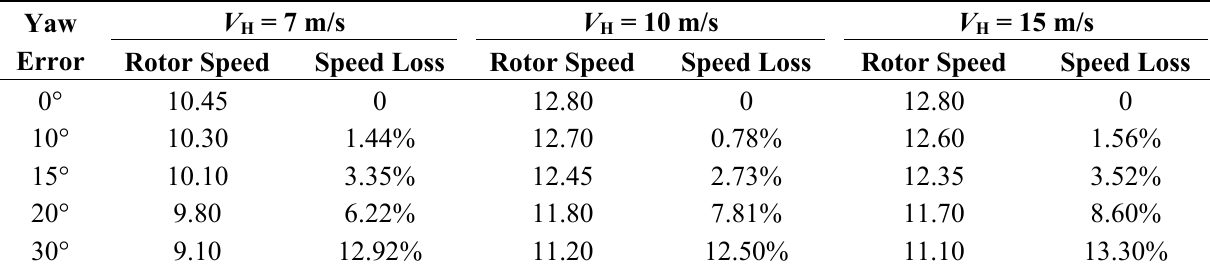
Table 4. Values of rotor speed